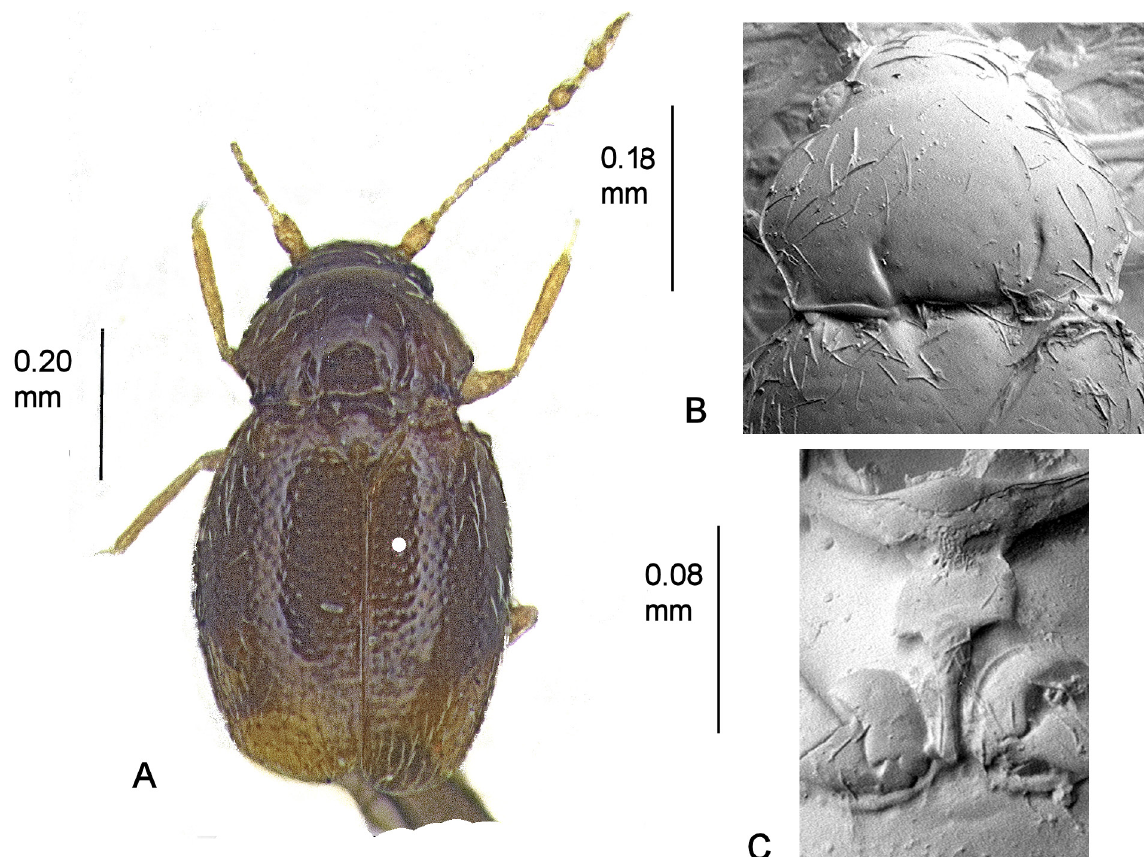
Fig. 64 . Cissidium arcuatum sp. nov. A . Habitus. B . Pronotum, × 425. C . Mesoventrite showing median process of collar, mid-keel and keel, ×